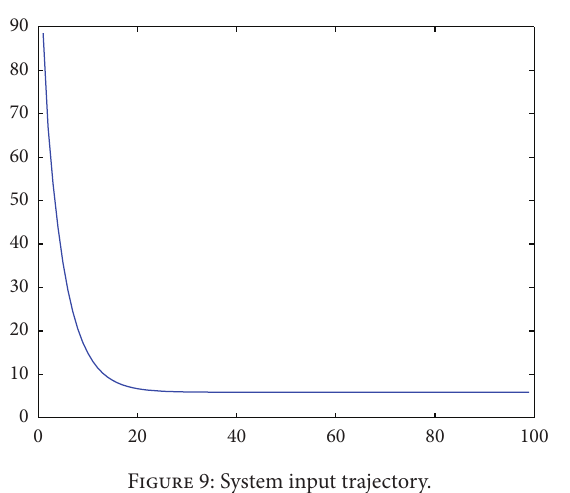
Figure 12: System output cell trajectory.